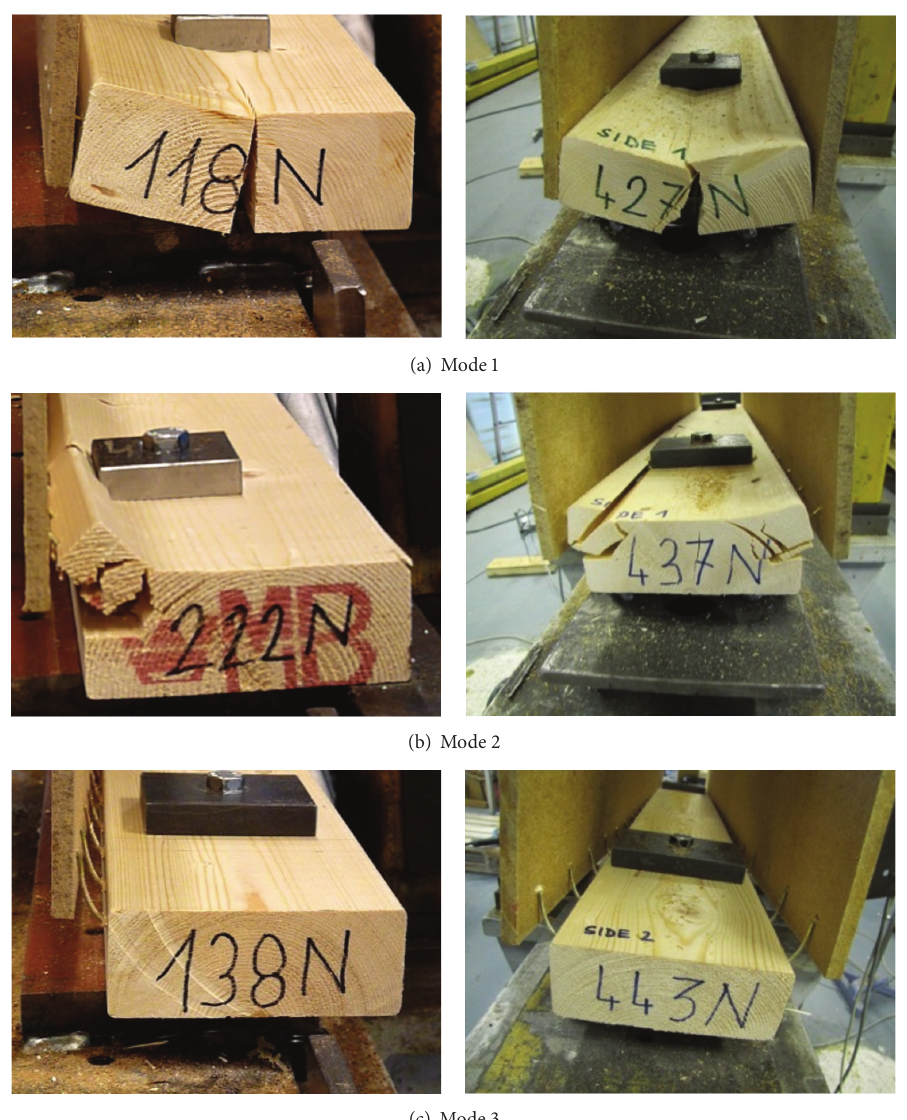
Figure 2: (a) Splitting failure along the bottom side of the rail; (b) splitting failure along the edge side of the rail; and (c) yielding and withdrawal of the nails in the sheathing-to-framing